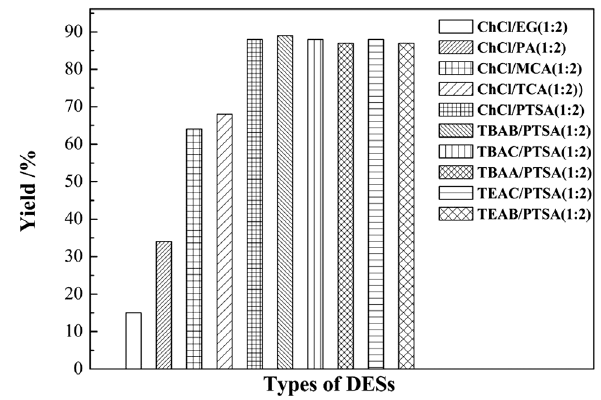
Figure 1: Effect of DESs types on reaction yield. Reaction conditions: benzaldehyde (2.0 mmol), ethyl